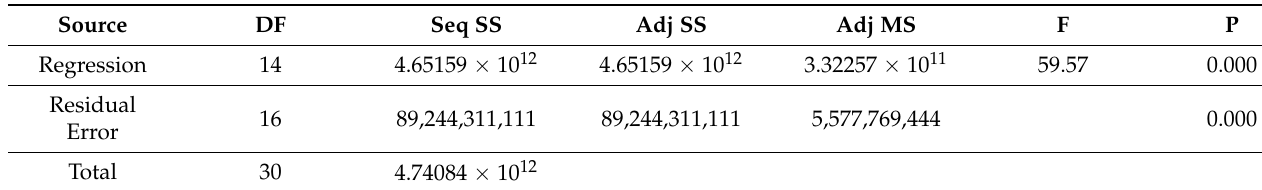
Table 11. Analysis of variance for electrical conductivity.